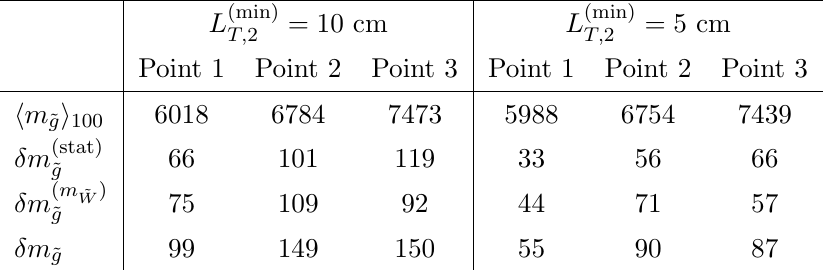
Table 5 . The mean of the peak position based on 100 data sets for each Sample Point, denoted as h m ~ g i 100 , as well as the uncertainty in the gluino mass determination (in units of GeV). The total uncertainty, (cid:14)m ~ g , is obtained by adding (cid:14)m (stat)